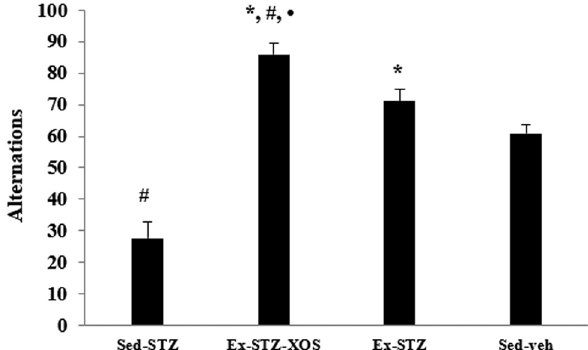
Figure 5: E ff ect of XOS and/or the aerobic training on the results from the Y - maze test. * Signi fi cant di ff erences in comparison to Sed - STZ; # signi fi cant di ff erences in comparison to Sed - veh; and (cid:129) sig - ni fi cant di ff erences in comparison to Ex - STZ.